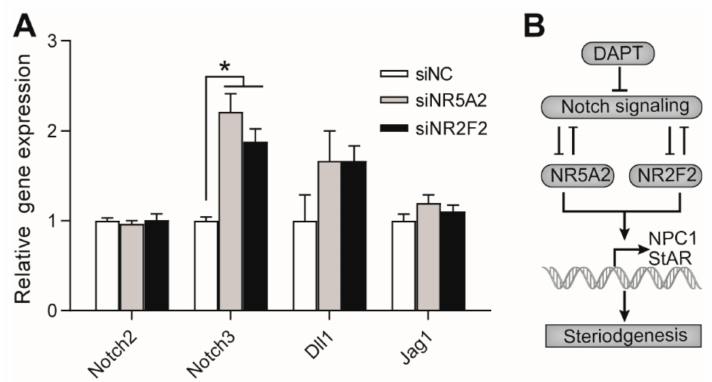
Figure 6. E ff ects of NR5A2 and NR2F2 knockdown on the expression of Notch receptors and ligands. ( A ) E ff ects of NR5A2 and NR2F2 on the expression of Notch receptors (Notch2 and Notch3) and Notch ligands (Dll1 and Jagged1). Primary pGCs were transfected with NR5A2 siRNA (siNR5A2), NR2F2 siRNA (siNR2F2), or scramble siRNA (siNC). ( B ) Schematic representation of the Notch / NR5A2 / NR2F2 pathway in regulating steroidogenesis pGCs. * means significant di ff erence at p <